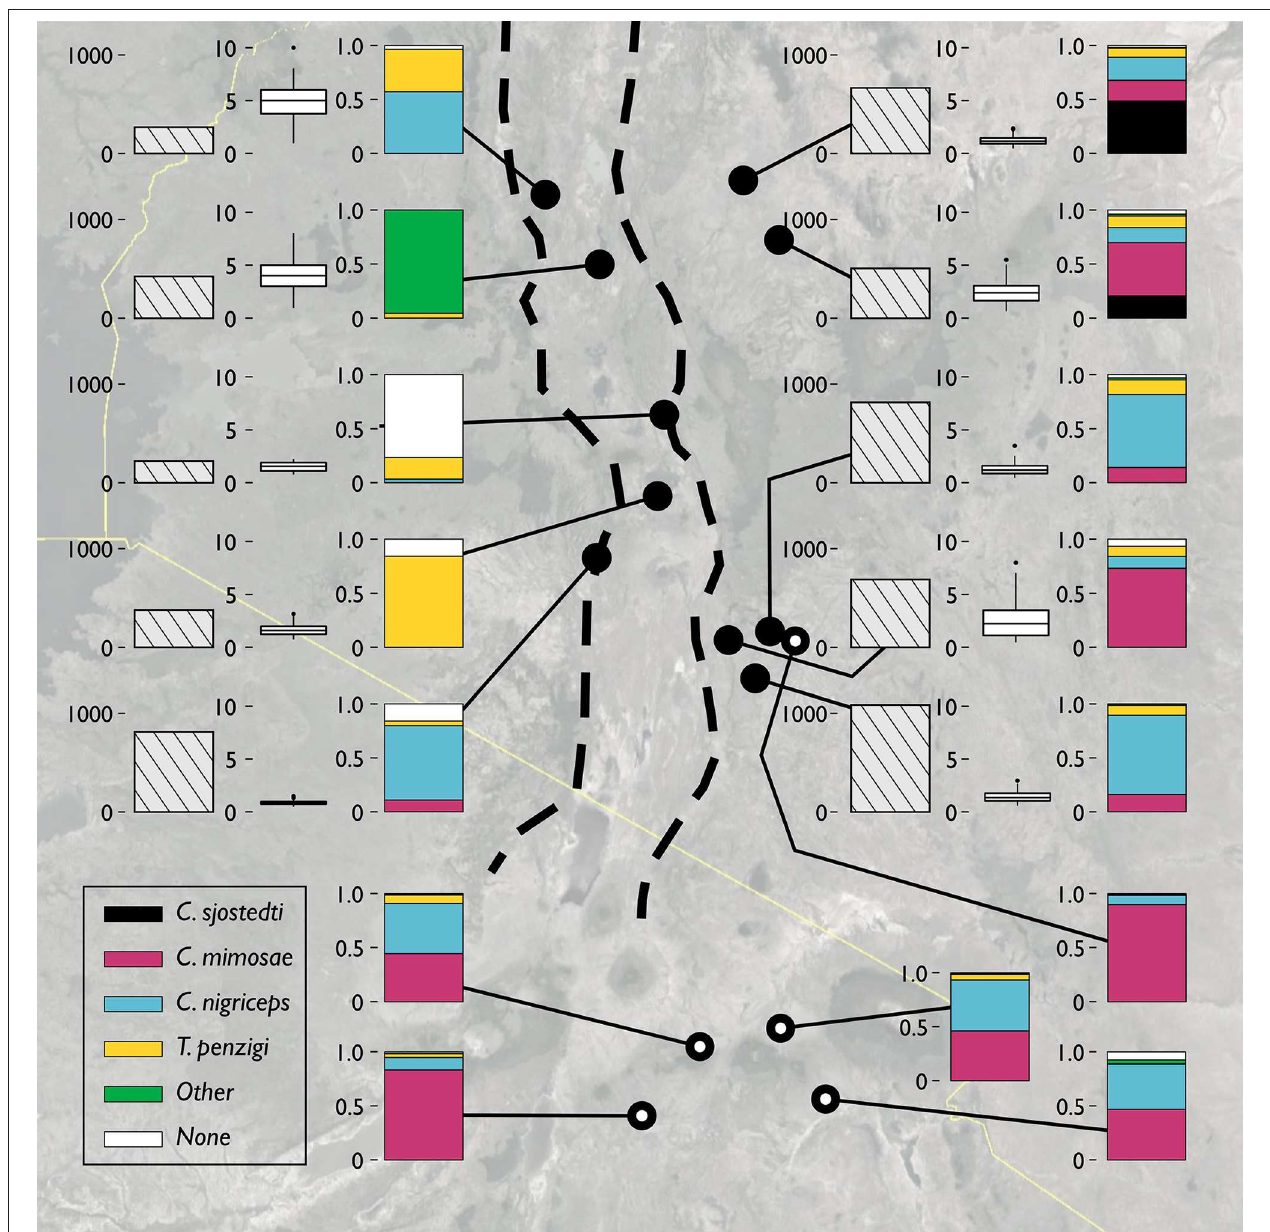
FIGURE 2 | The V. drepanolobium ant-plant symbiosis varies across Kenya. Three plots summarize the characteristics of each site. The leftmost bar shows tree density, in trees/hectare. The middle box and whisker plot shows the distribution of tree heights (in meters) at each site. The rightmost bar shows the proportions of those trees occupied by each species of ant. “Other” indicated trees occupied by another species of ant, e.g., Lepisiota sp at Mogotio, or by more than one species of ant. “None” indicates that no colony appeared to occupy the tree. Sites marked by hollow circles are from Hocking (1970). Map image: Google, Landsat/Copernicus, US Dept. of State Geographer, Data SIO, NOAA, U.S.Navy, NGA, GEBCO.